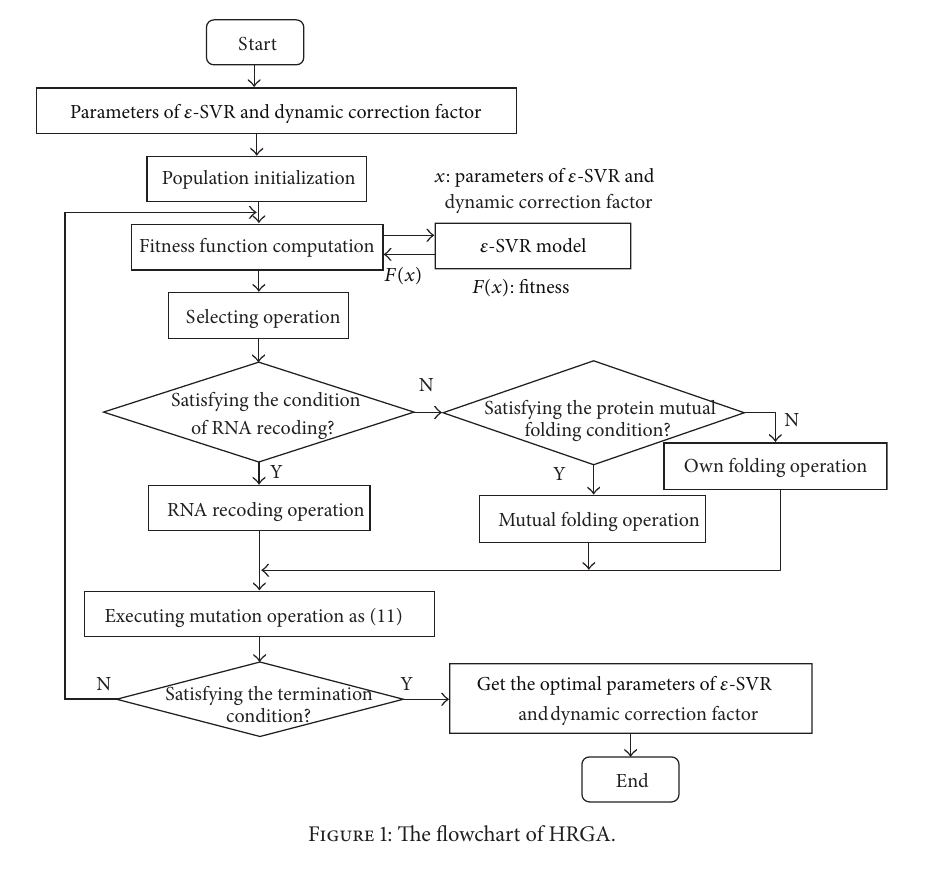
Figure 1: The flowchart of HRGA.